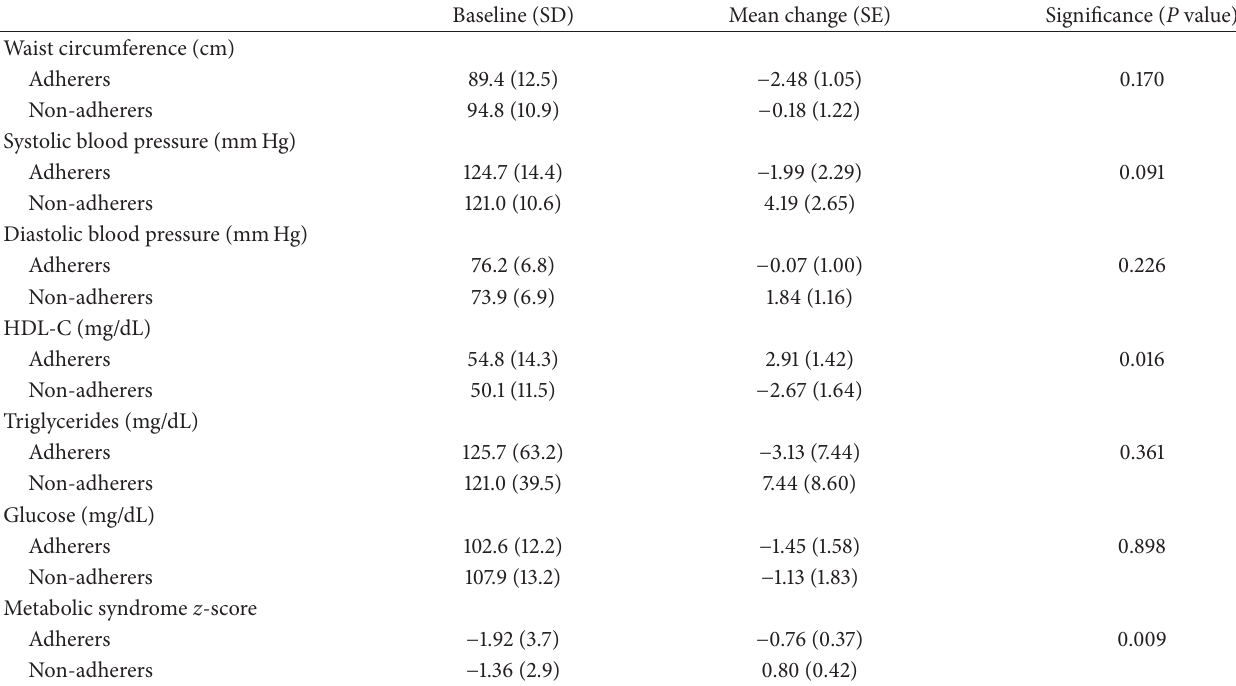
Table 4: Six-month change in metabolic syndrome variables in exercise adherers ( 𝑛 = 20 ) versus nonadherers ( 𝑛 = 15